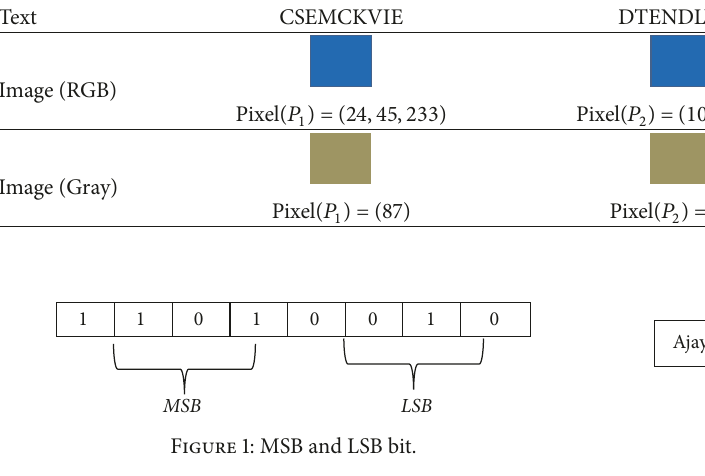
Figure 1: MSB and LSB bit.